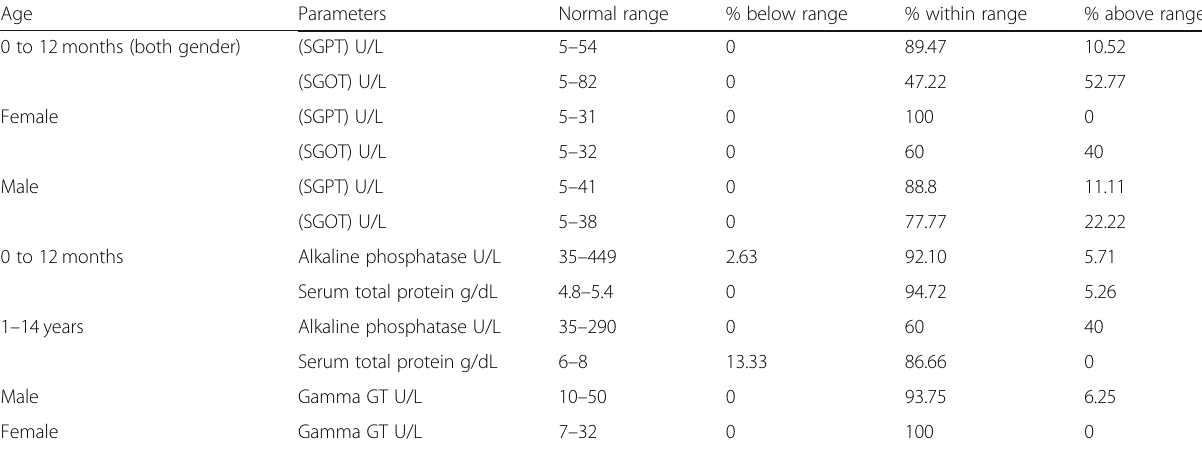
Table 3 Liver function analysis in study population